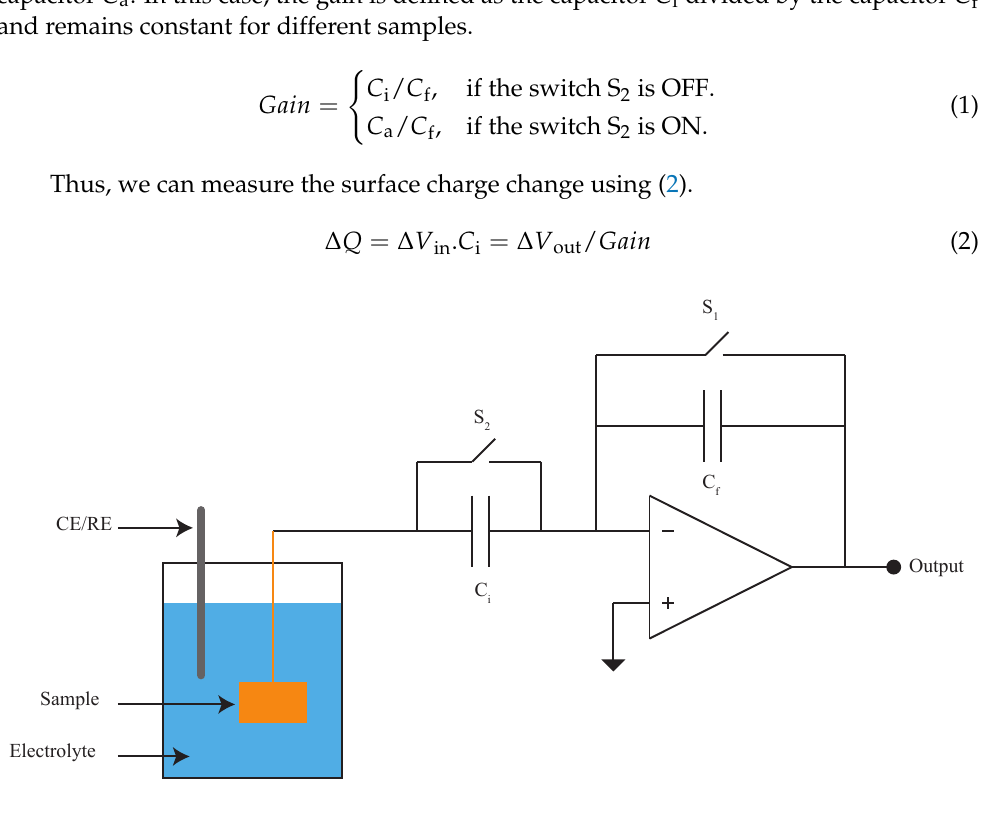
Figure 3. Switched capacitor amplifier circuit for measuring the sample’s capacitance and the surface charge